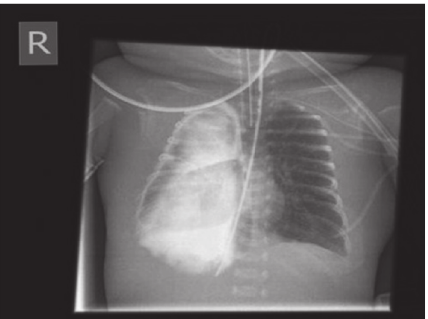
Figure 1: Chest radiograph after contrast agent application showing massive effusion in the pleural cavity and abnormal right-sided position of the nasogastric